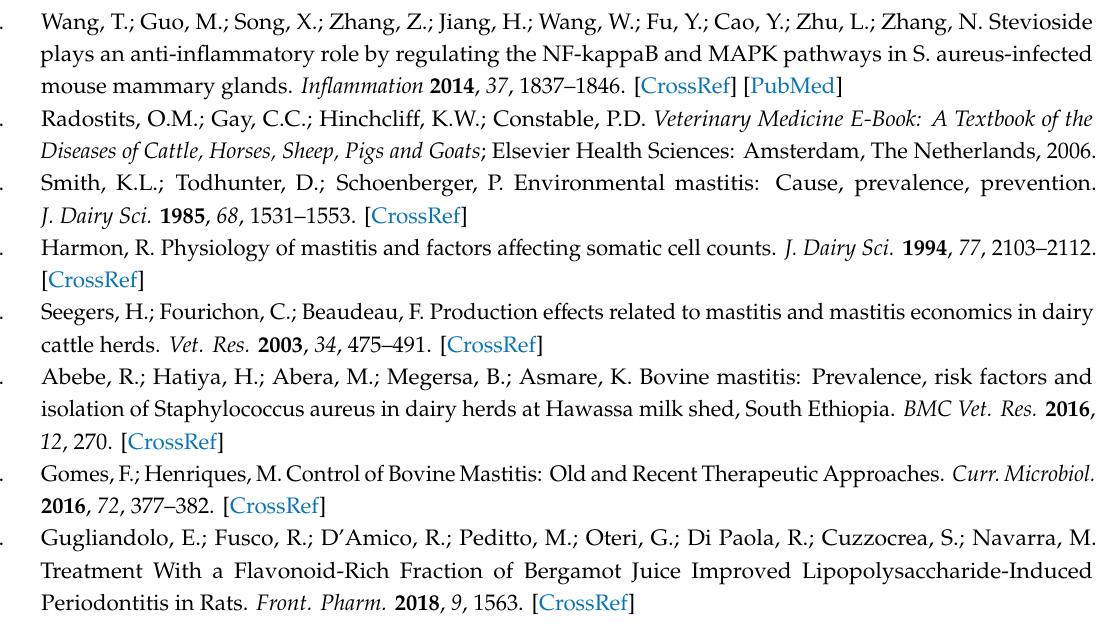
Table S1: E ff ects of HT on cell viability MTT assay, Table S2: E ff ects of HT on inflammation and oxidative stress in MAC-T cells stimulated with LPS for 1 h, Table S3: E ff ects of HT on inflammation and oxidative stress in MAC-T cells stimulated with LPS for 6 h, Table S4: E ff ects of HT on casein isoforms in di ff erentiated MAC-T